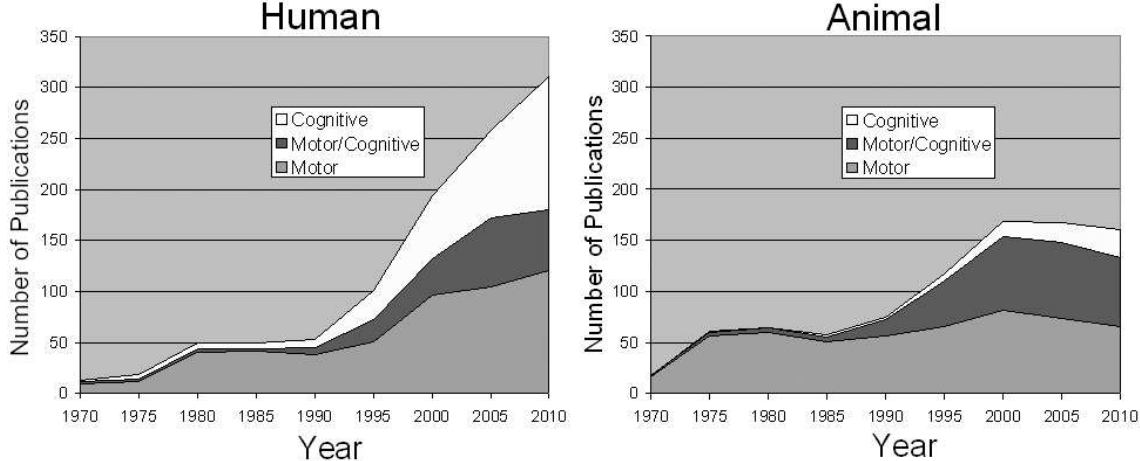
Fig. 1. Trends over time in human and animal publications pertaining to cerebellar function. Articles were classified as to whether they investigated cognitive, motor/cognitive, or motor functions of the cerebellum, using article title search criteria indicated in the text. The number of publications depicted at each year point on the X axis represents the counts of articles in the 5 years prior to that date. So for example, on the Animal graph, the number of publications appearing above the year 2000 is 168. This represents the number of animal articles whose year of publication was less than 2000 and greater than or equal to 1995. A total of 81 motor articles, 73 motor/cognitive articles, and 14 cognitive articles were obtained during that 5-year